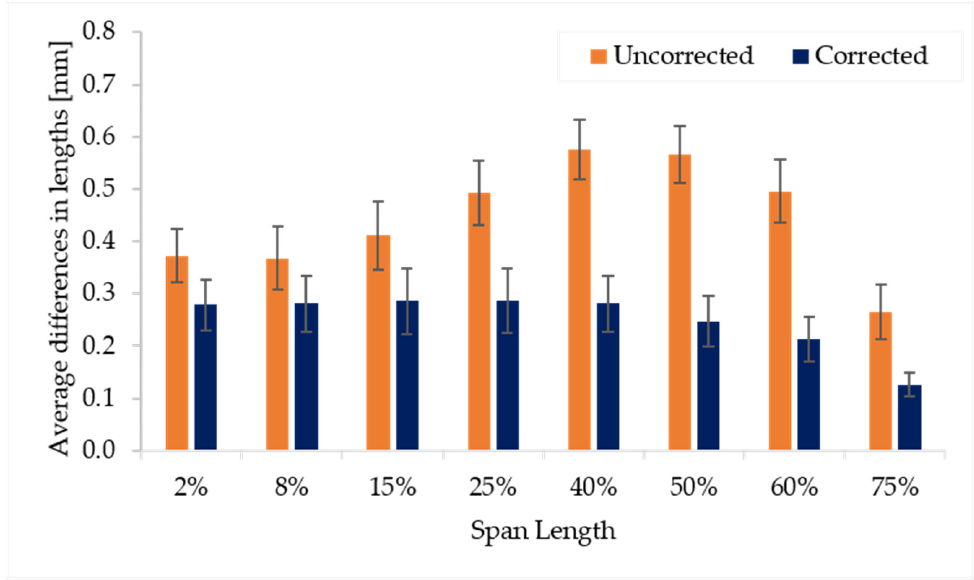
Figure 13. Average differences in length across HVI pairs and samples before and after